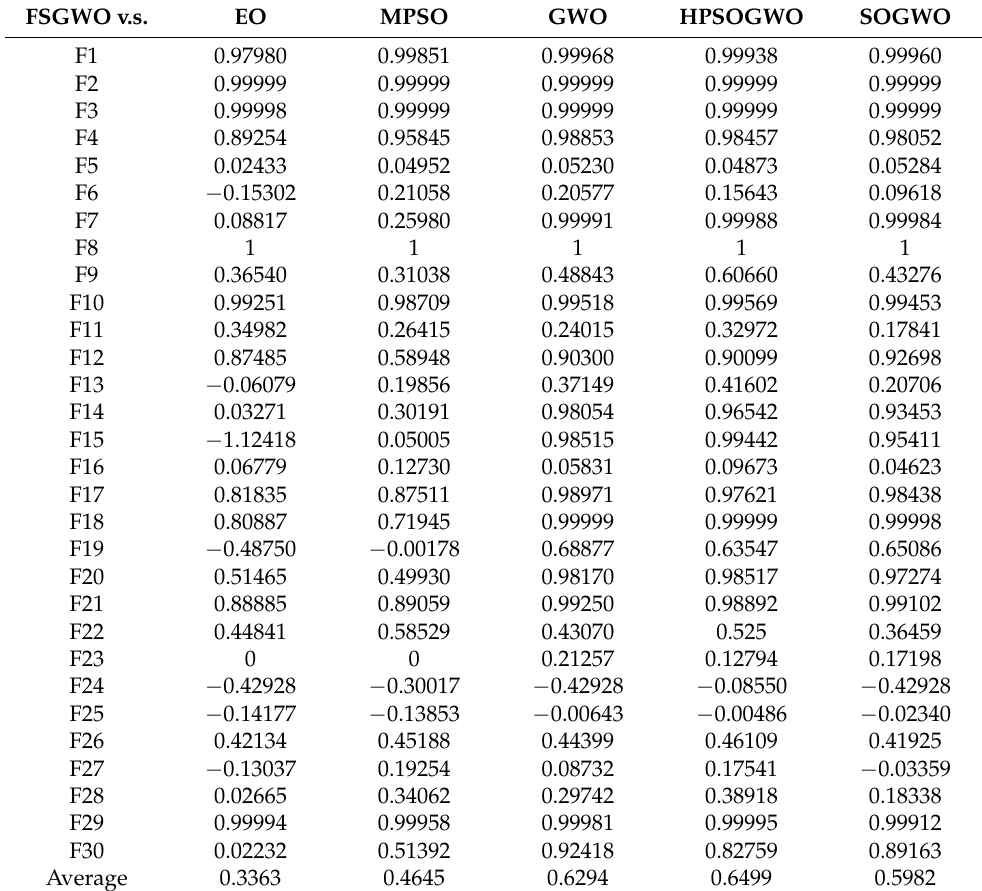
Table 7. Comparison of the calculation accuracy of related algorithms for 30 50-D test